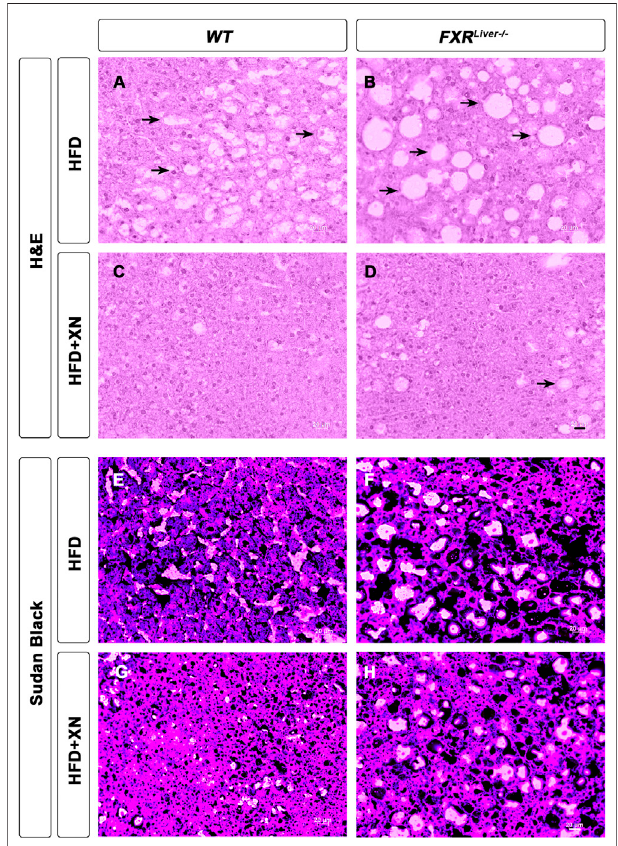
FIGURE 1 | XN prevents HFD-induced hepatic steatosis. Representative liver histology by H&E (A-D) and Sudan Black (E-H) of male WT and FXR Liver − / − mice fed HFD ± XN. Arrows indicate vacuoles, a characteristic structure of hepatic